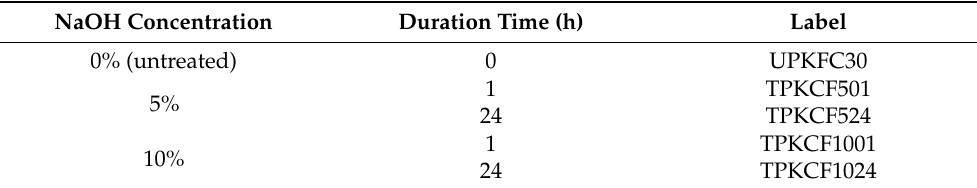
Table 3. Surface modification with alkaline treatment of PKCF/ER